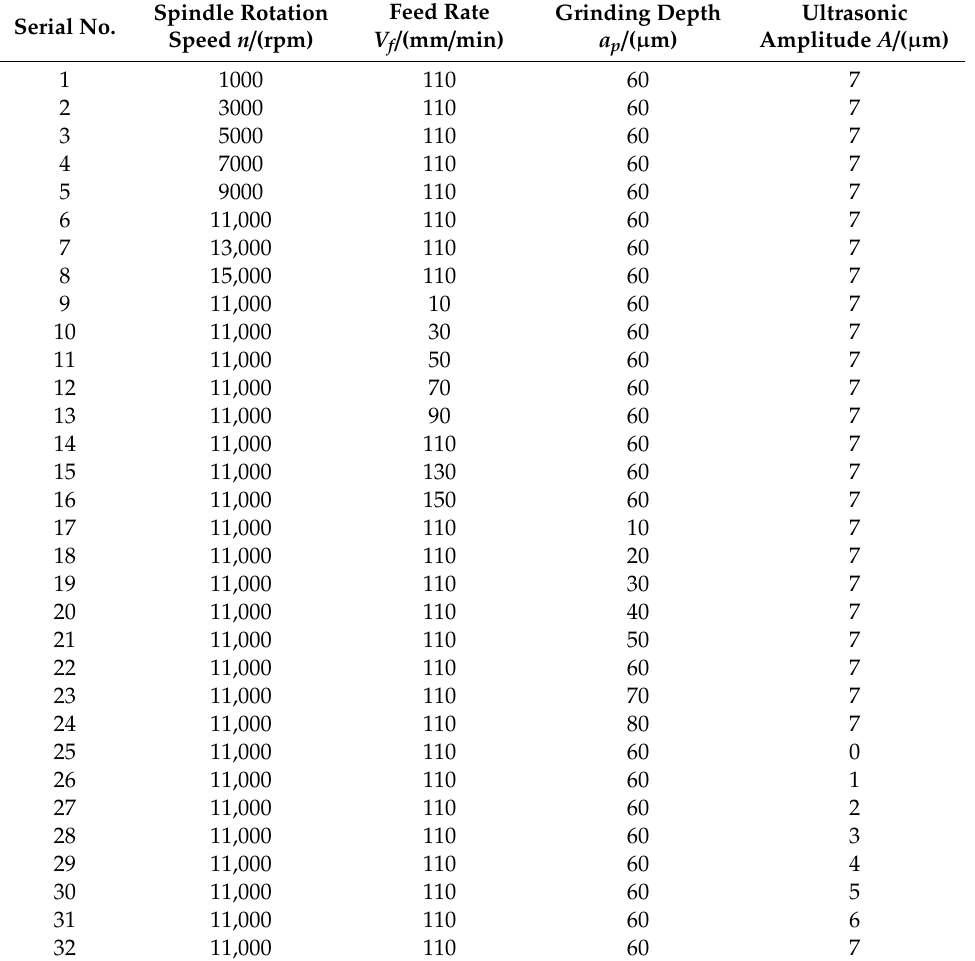
Table 1. Machining parameters in ultrasonic vibration assisted grinding experiments of BK7 optical glass.